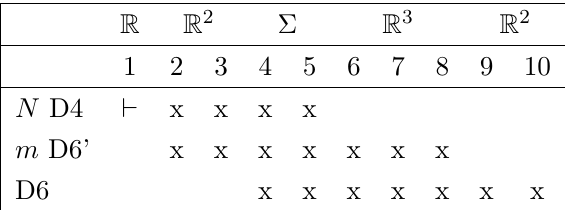
Table 6. Type IIA setup in the pole region after reduction on the circle of